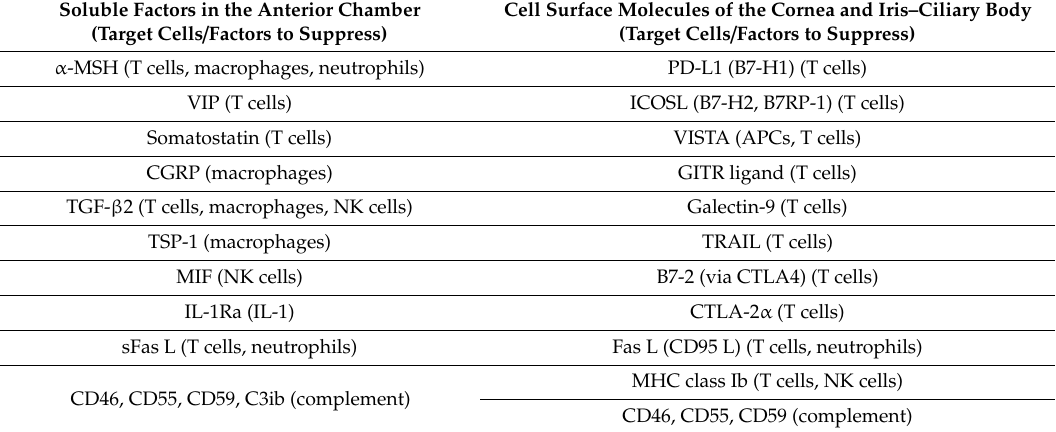
Table 1. Immunomodulatory factors expressed in the anterior segment of the eye. Reprinted from Prog Retin Eye Res. 72, 100758. Hori, J.; Yamaguchi, T.; Keino, H.; Hamrah, P.; Maruyama, K. Immune privilege in corneal transplantation. Copyright (2019), with permission from Elsevier